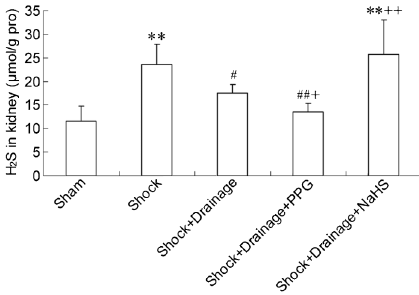
Figure 1. Changes in hydrogen sulfide (H 2 S) levels in rat kidneys. Data are reported as means±SD ( m mol/g protein, n=6). PPG: D,L- propargylglycine; NaHS: sodium hydrosulfide hydrate. **P , 0.01 vs theshamgroup; # P , 0.05, ## P , 0.01 vs theshockgroup; + P , 0.05, ++ P , 0.01 vs the shock++drainage group (one-way ANOVA).